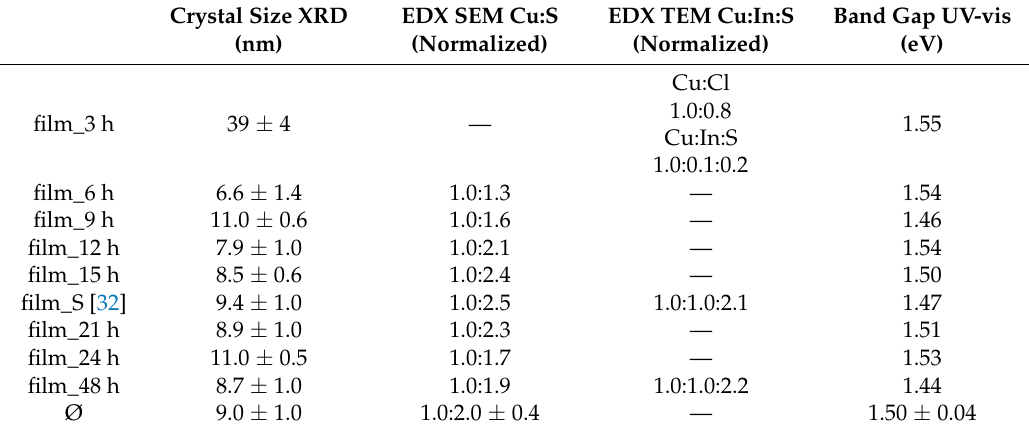
Table 1. Summary of crystal size, determined with XRD, normalized elemental composition (Cu:S for SEM, Cu:In:S for STEM measurements) and band gap of the CuInS 2 films synthesized with L -cysteine for different reaction times at 150 ◦ C. Values of film_3 h are not included in the average value in the last